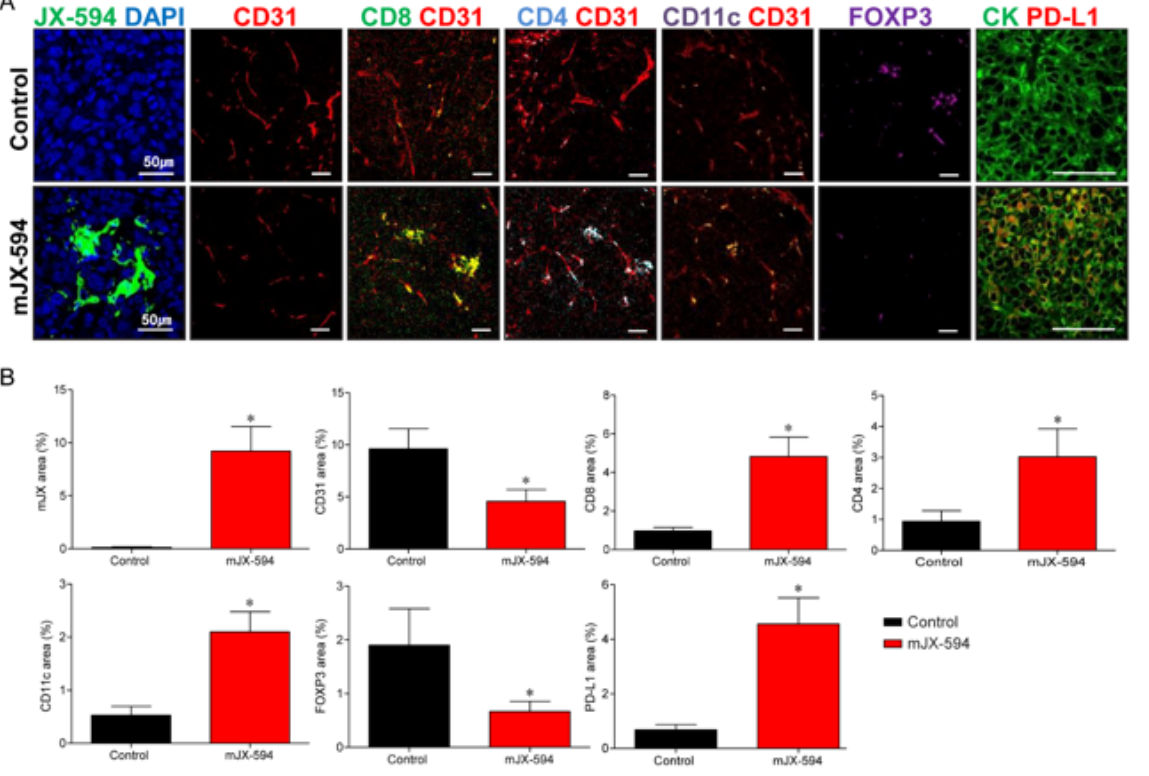
Figure 4. mJX-594 systemic treatment activates anti-cancer immunity by converting immunosuppressive noninflamed tumors into inflamed tumors at primary tumor. ( A ) Representative images of